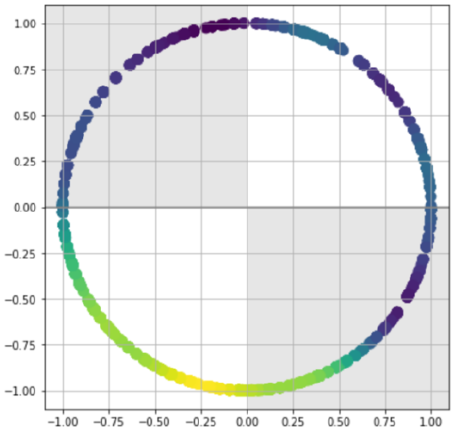
Fig. 2: Sin_time and Cos_time functions, related to the radiant